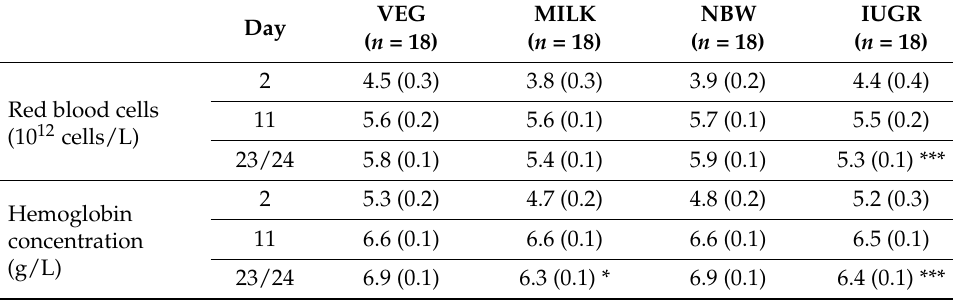
Table 2. Development of hematological parameters, stratified by diet and birthweight